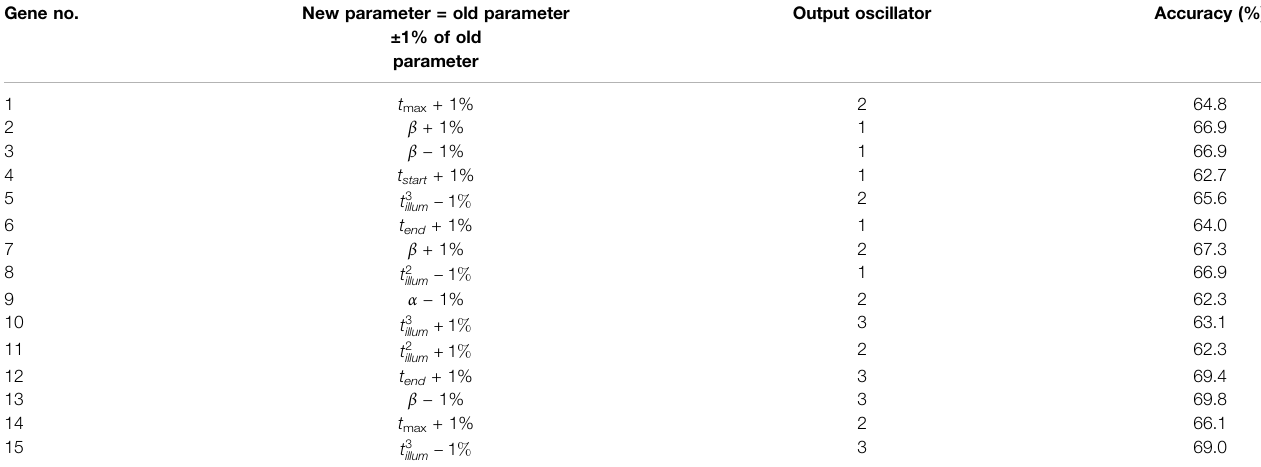
TABLE 6 | The accuracy of modi fi ed oscillator networks for correlations between the gene expression value and the therapy result. The table also de fi nes modi fi cation introduced to the optimized network. Gene no.